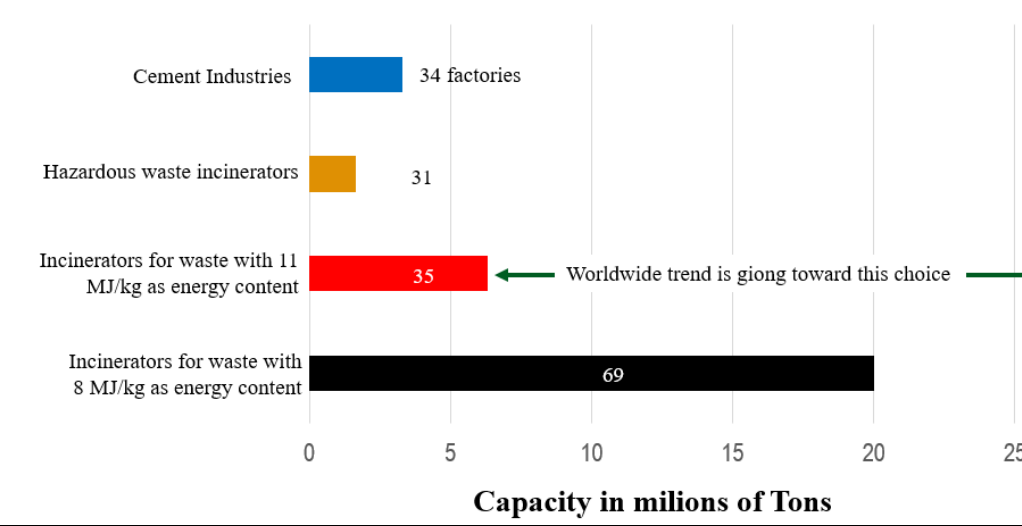
Figure 1. Distribution of waste incineration plants in Germany according to heat content, adapted from the German Environment Agency report [2,7].